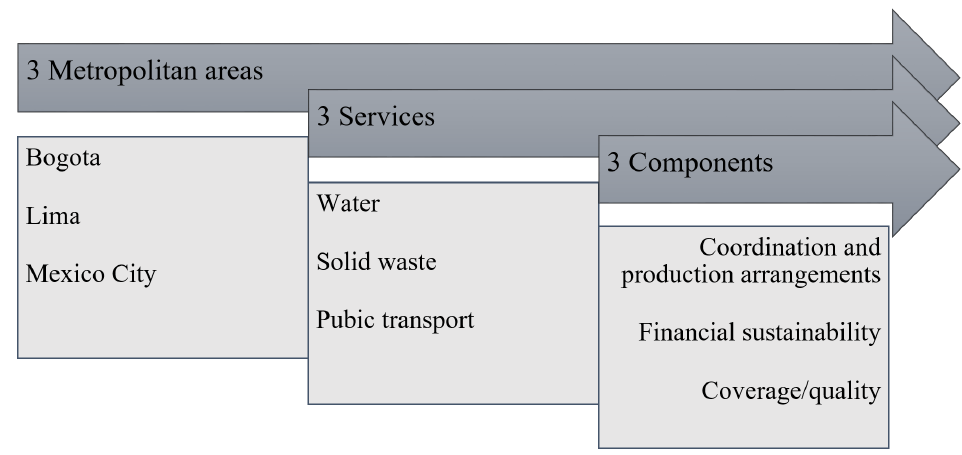
Figure 1: Metropolitan governance organization